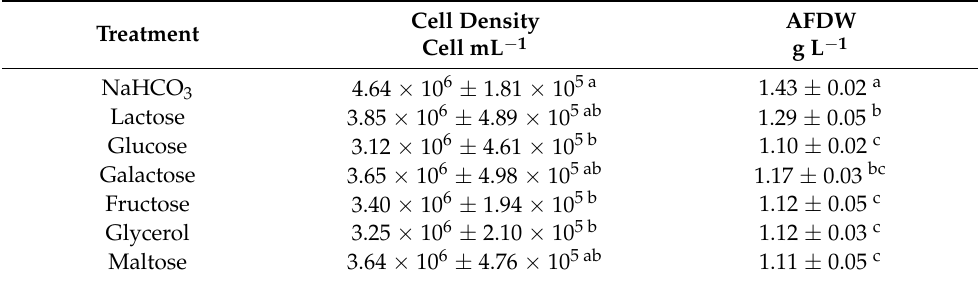
Table 3. Cell density and AFDW using different carbon sources in the mixotrophic